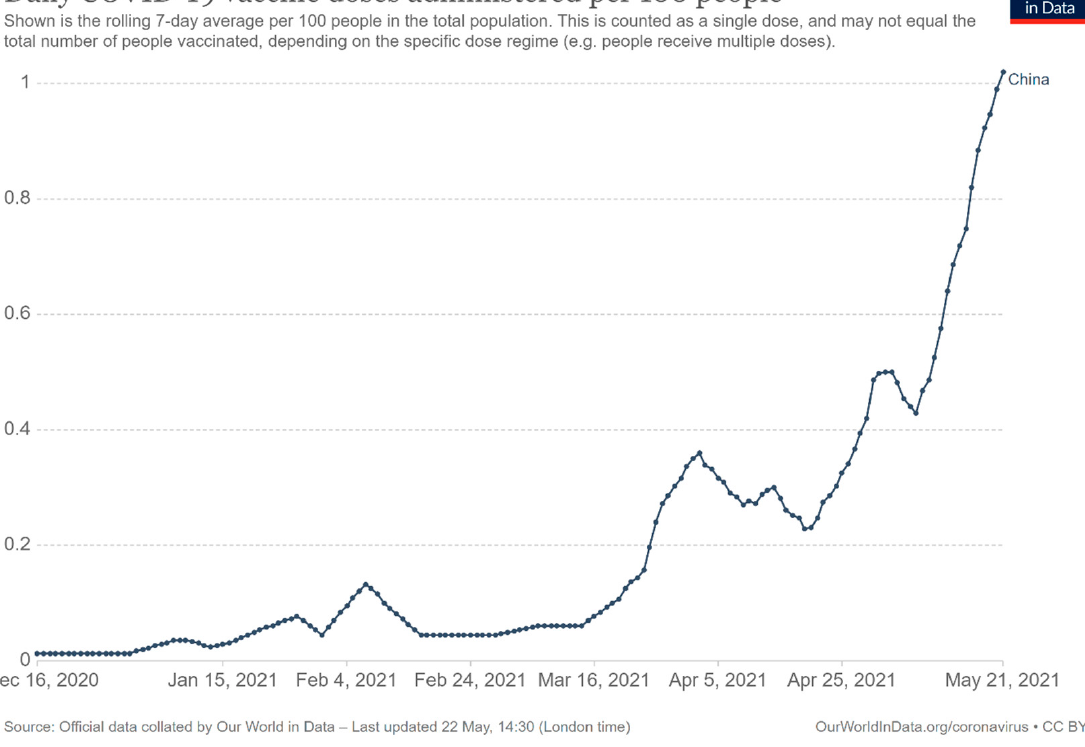
Figure 3. Daily COVID-19 vaccine doses administered per 100 people in China [19].